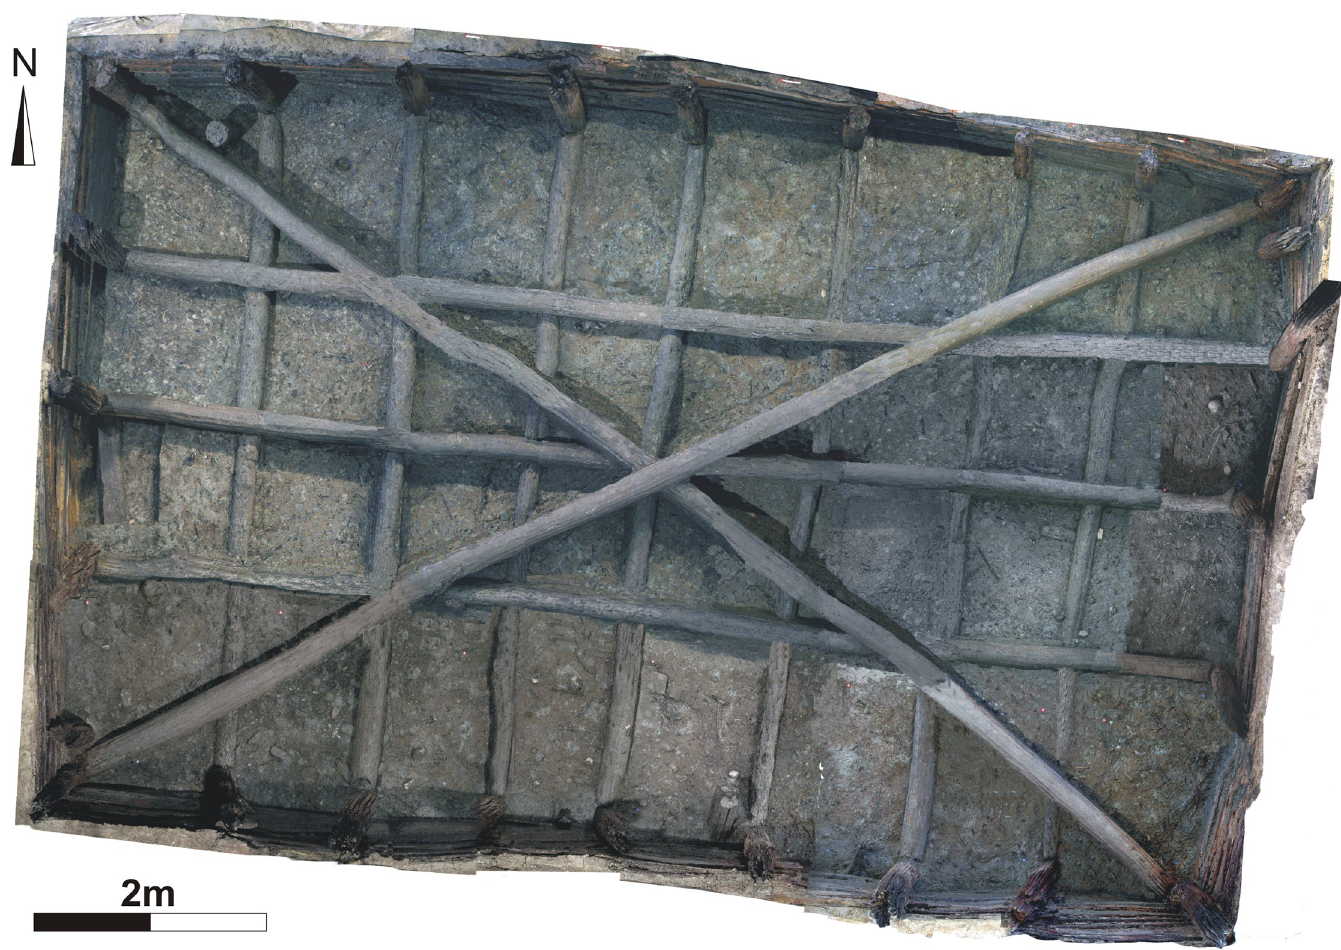
Fig 5. Overhead photogrammetric plan image of the upper tank at